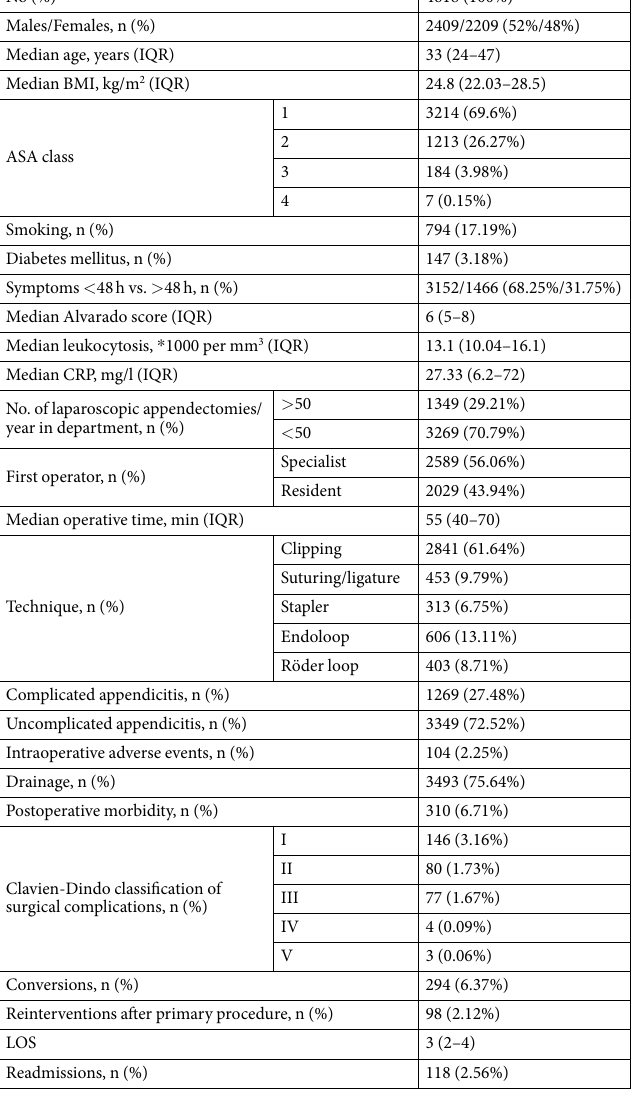
Table 1. General group